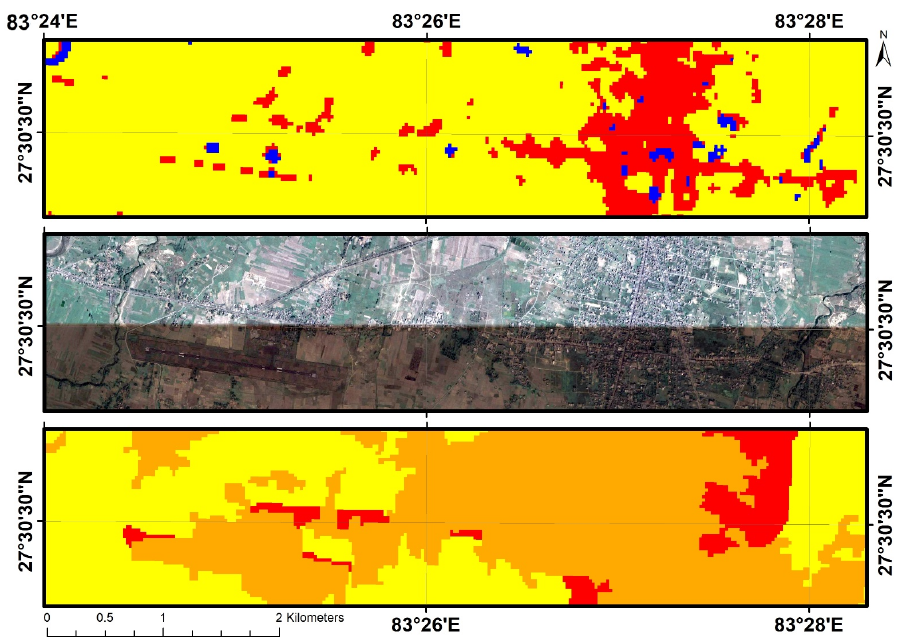
Figure 8. Comparison of LC map around Bhairahawa and Gautam Buddha airport area for the year 2010 from top to bottom: 30-meter map obtained from our study, high-resolution imagery from Google Earth Pro (GEP), and national map prepared by ICIMOD.